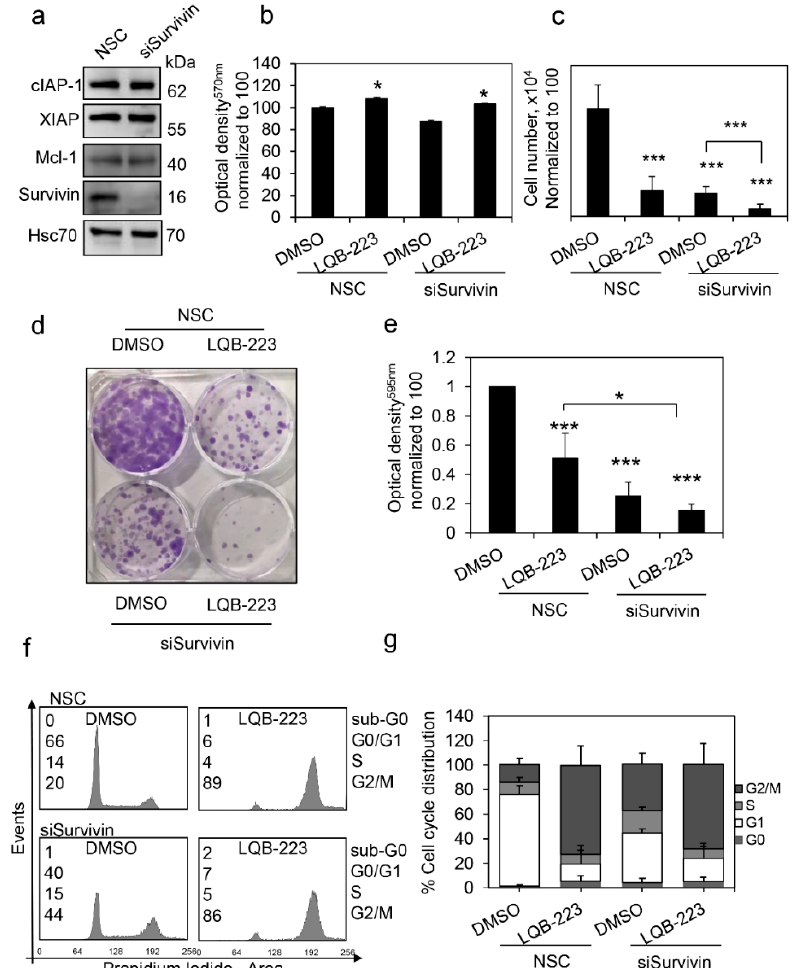
Figure 7. Analysis of the role of survivin in MDA-MB-231 cells’ sensitivity to LQB-223. ( a ) Modulation of chemoresistance-related proteins upon survivin inhibition in MDA-MB-231 Cells. ( b ) Cell viability of MDA-MB-231 cells after exposure to LQB-223 or / and survivin inhibition. ( c ) Cell count using trypan blue after exposure to LQB-223 or / and survivin inhibition. ( d ) Clonogenic assay after treatment with LQB-223 or / and survivin inhibition. ( e ) Absorbance of colonies of MDA-MB-231 stained with crystal violet shown in ( d ). ( f ) Analysis of cell cycle phases distribution after treatment with LQB-223 or / and survivin inhibition by means of flow cytometry. ( g ) Cell cycle distribution of MDA-MB-231 cells after treatment with LQB-223 or / and survivin inhibition. Values reported as percentage of cells in each cell cycle phase.. Values reported as mean and standard deviation of three independent experiments and statistical analysis were performed using the Student’s t test (* p < 0.05; *** p < 0.001).